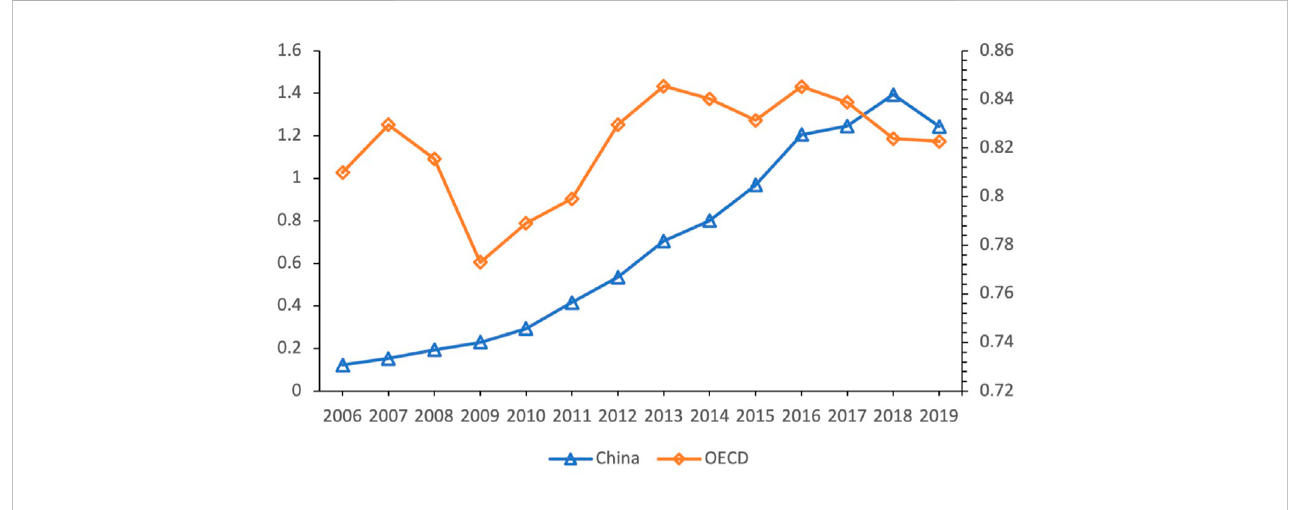
FIGURE 1 Number of patents per